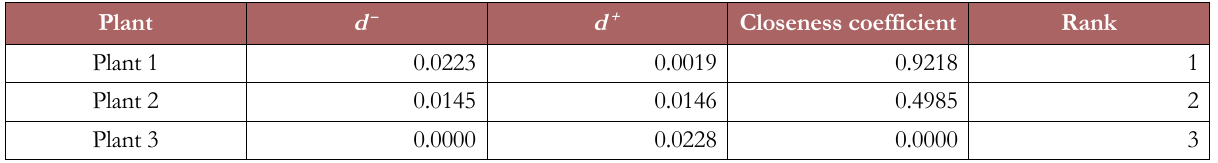
Table 14. Distance, closeness coefficient and the rank of each plant (advanced simulation)